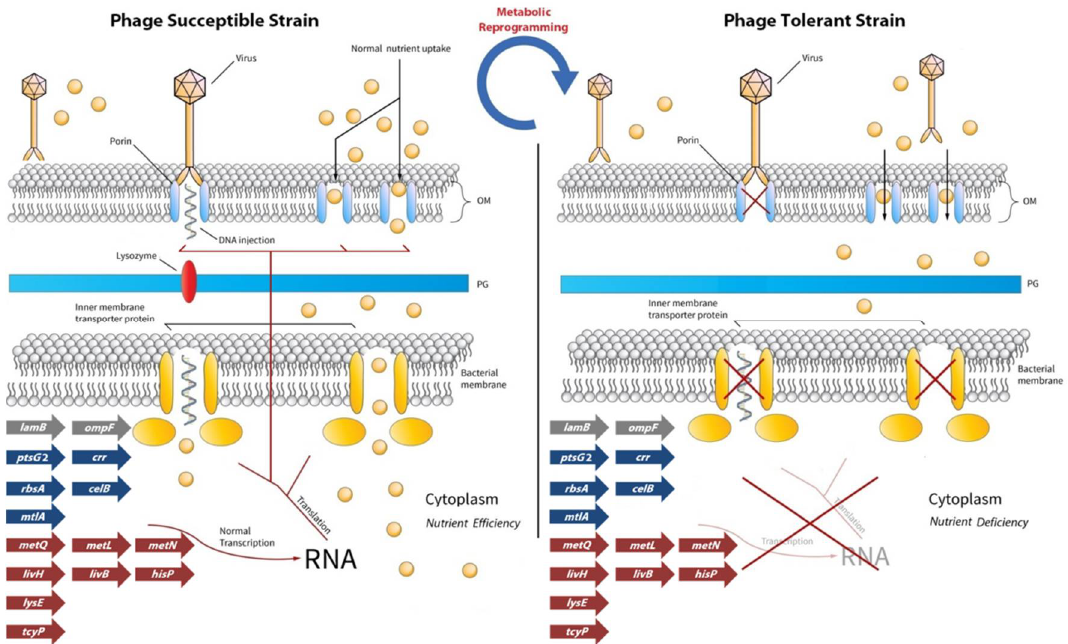
Figure 7. Schematic representation of how metabolic reprogramming of bacterial cells could introduce phage resistance against lytic bacteriophages after phage–host interaction. Arrows represent genes (as seen in Table 3) involved in nutrient assimilation or exportation for which their relative transcript levels were significantly downregulated compared to the control (wild-type) strains in the current study. Gray: outer membrane receptors ( lamb and ompF ); Blue: inner bacterial membrane sugars and polyols ( ptsG 2, crr, rbsA , celB, mtlA ); Red: inner bacterial membrane amino acids ( metQ , metL metN , livH , livB and hisP ). OM: outer membrane; PG: peptidoglycan layer.